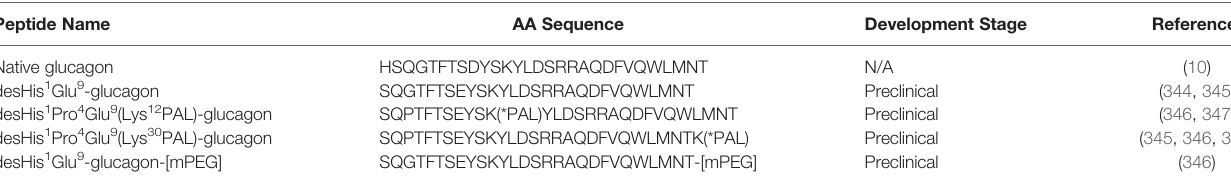
TABLE 6 | Glucagon antagonist peptides for T2DM.